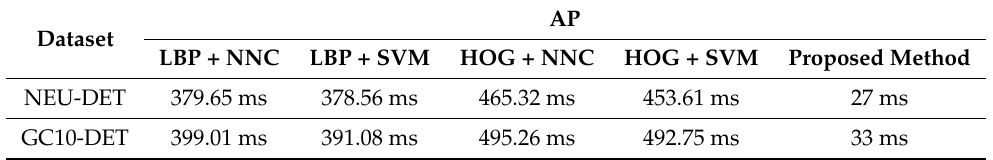
Table 7. Comparison of Computational Time on Two datasets for deep methods.